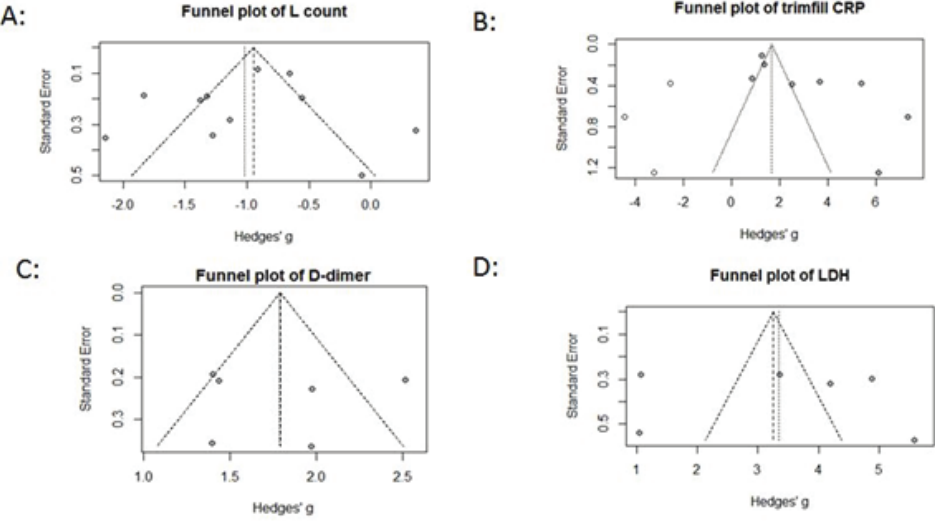
Figure 6: (A–D) Funnel plots for assessment of the publication